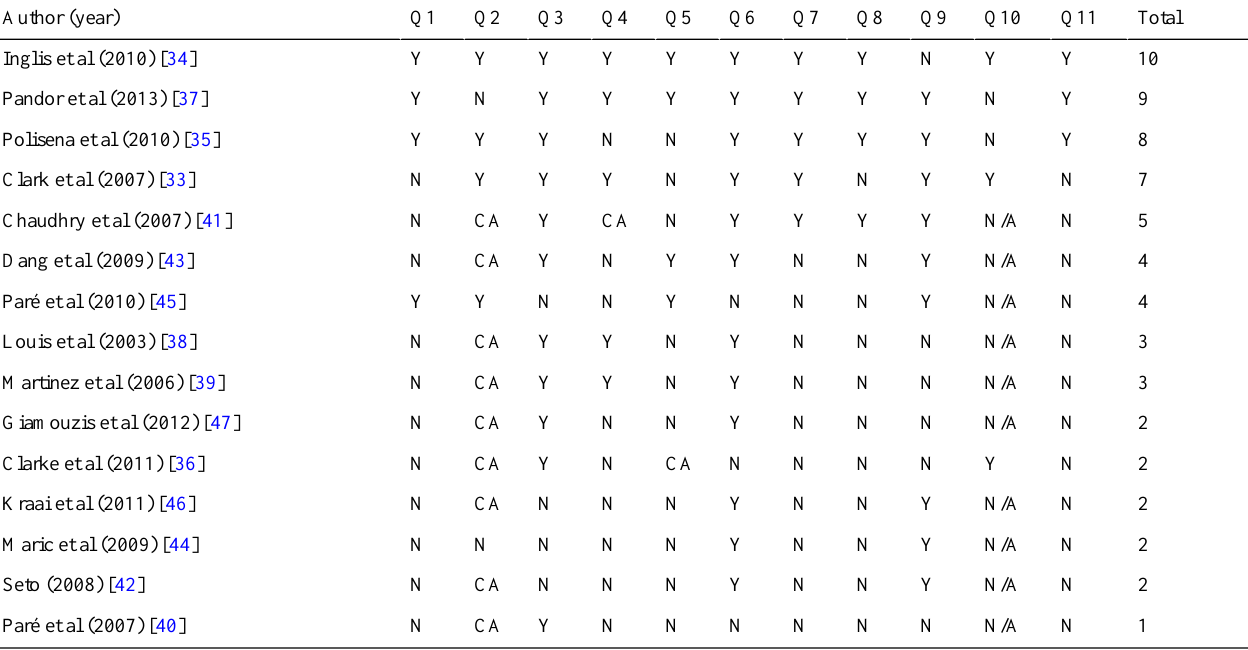
Table 5. Methodological quality of systematic reviews based on AMSTAR criteria and scores.